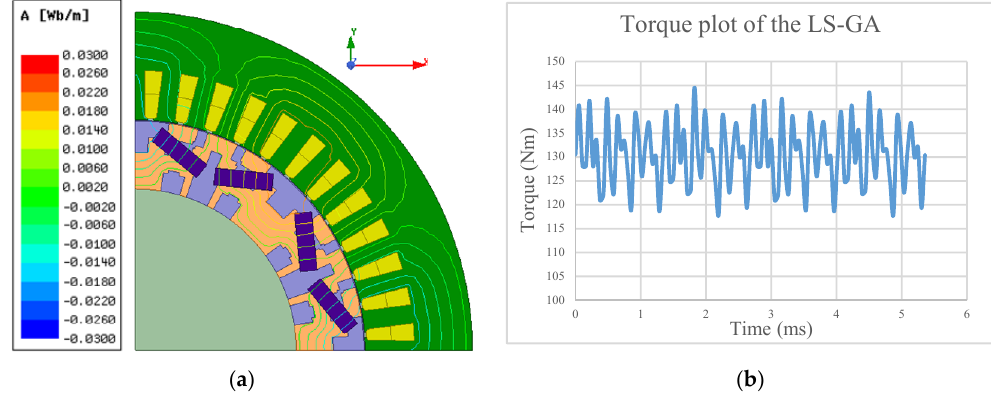
Figure 5. The Optimized design of IPM obtained by the LS-GA: ( a ) cross-section; and ( b ) torque plot.